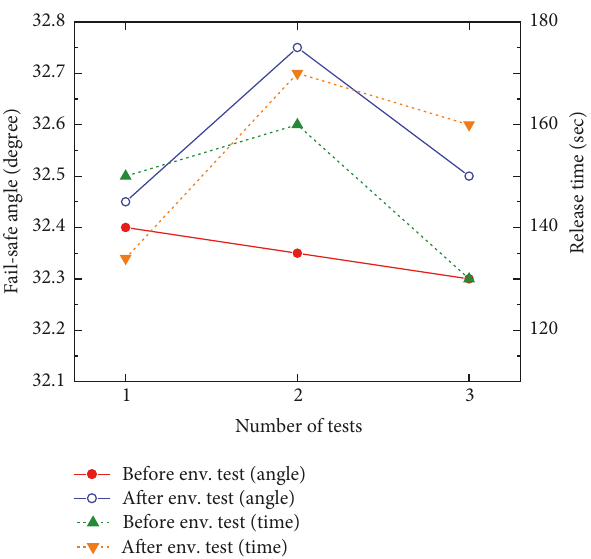
Before env. test (time) After env. test Figure 15: Measured fail-safe angle values before and after launch environment